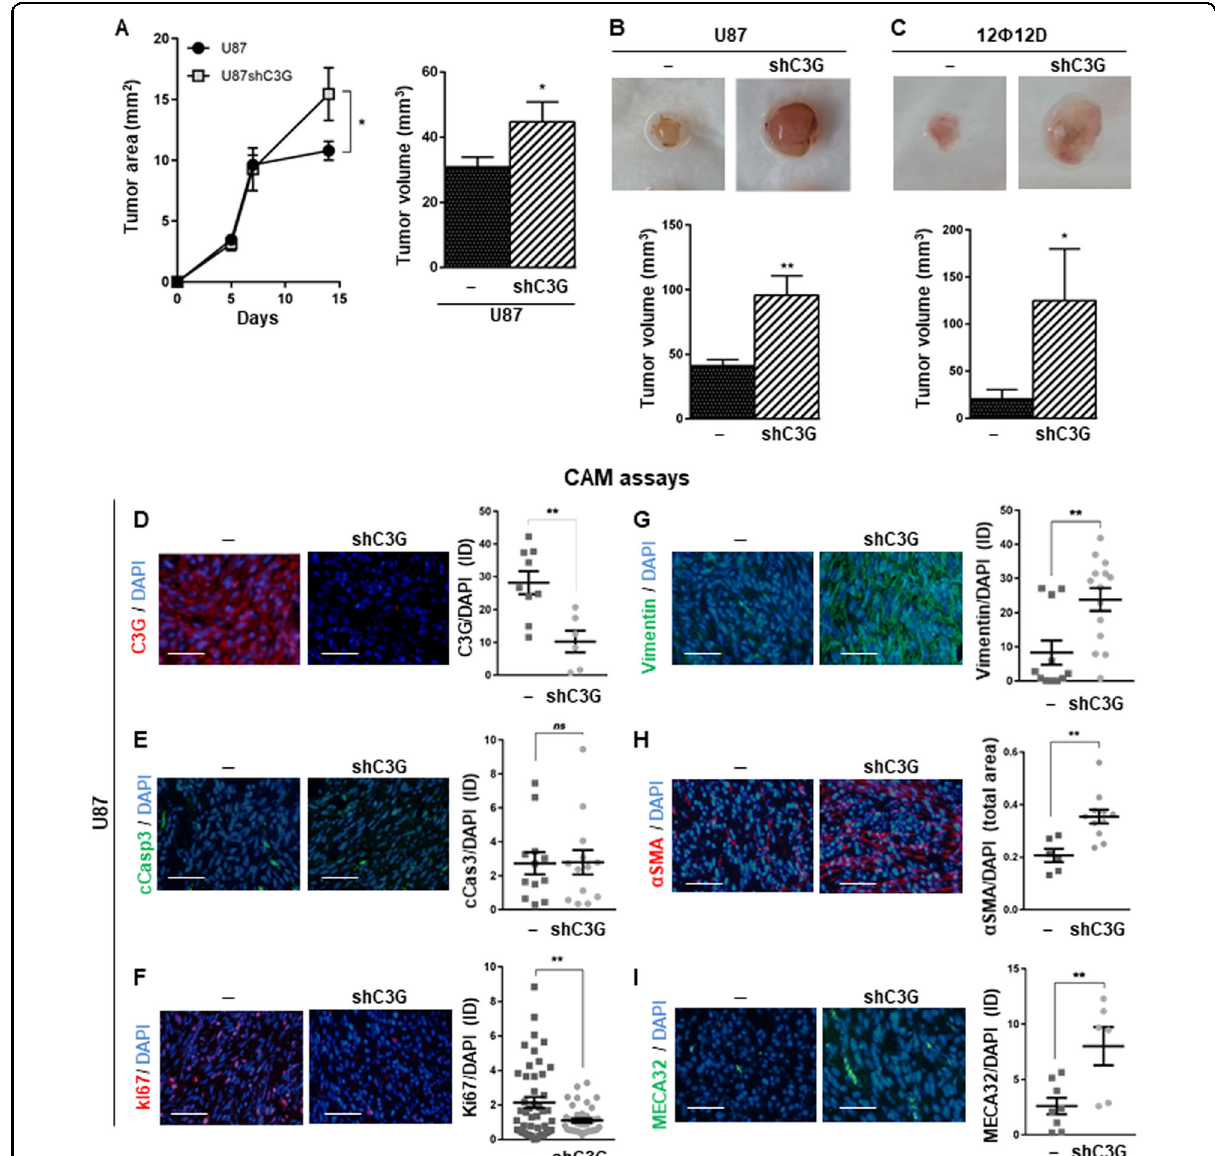
Fig. 4 Effect of C3G knock-down on in vivo tumor growth. A Xenograft assay using U87 cells. Left panel, graphic showing the mean value of tumor area along the time (0 – 15 days) ± S.E.M. (two independent experiments, 5 mice/each); right panel, histogram represents the mean value of tumor volume ± S.E.M. at the end-point (15 days). B CAM assays using U87 and 12 Ф 12D cells. Top panels, representative tumors at the end point (7 days); lower panels, histogram represents the mean value of tumor volume ± S.E.M. (three independent experiments, total number of chick embryos 13) at the end point. D – I Immuno fl uorescence microscopy analysis in tumors generated by U87 cells in CAM assays of ( D ) C3G (red), E cleaved caspase 3 (cCasp3 (green)), F Ki67 (green), G Vimentin (green), H α -Smooth muscle actin ( α -SMA ( red )) and I MECA 32 (green). Cell nuclei were stained with DAPI (blue). Left panels, representative images; right panels, graphs represent integrated density mean values normalized with DAPI-positive area ± S.E.M. ( n = 3). ** p ≤ 0.01, compared as indicated. Scale bars: 100